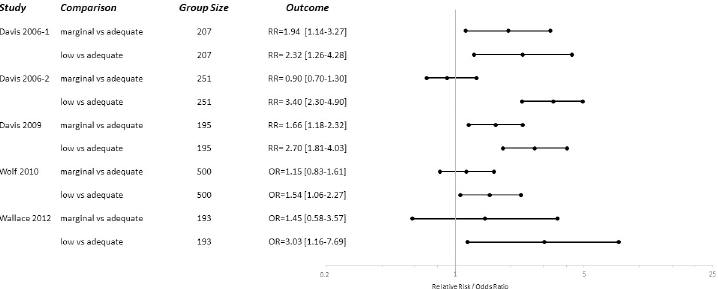
Fig 4. Relative risks and odds ratios of misunderstanding of patients with marginal/low health literacy compared to patients with adequate health literacy.